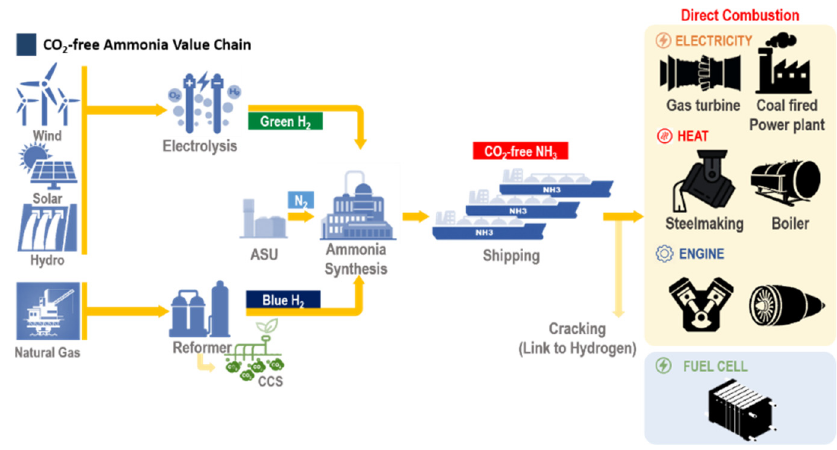
Figure 1. A schematic flow on CO 2 -free ammonia value chain.